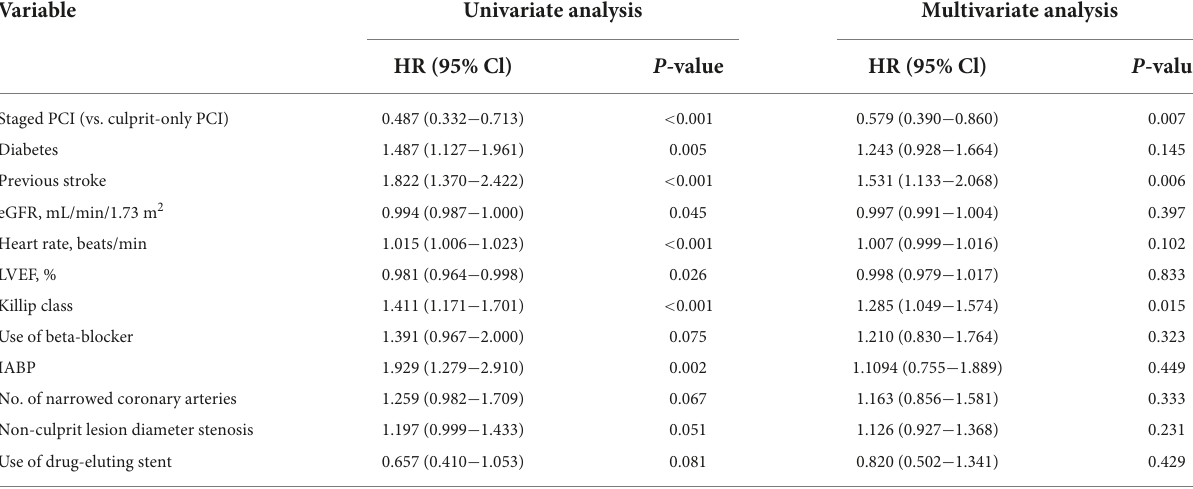
TABLE 4 Cox proportion hazards analysis for predictors of major adverse cardiac and cerebrovascular events (MACCE) before PSM analysis. Variable